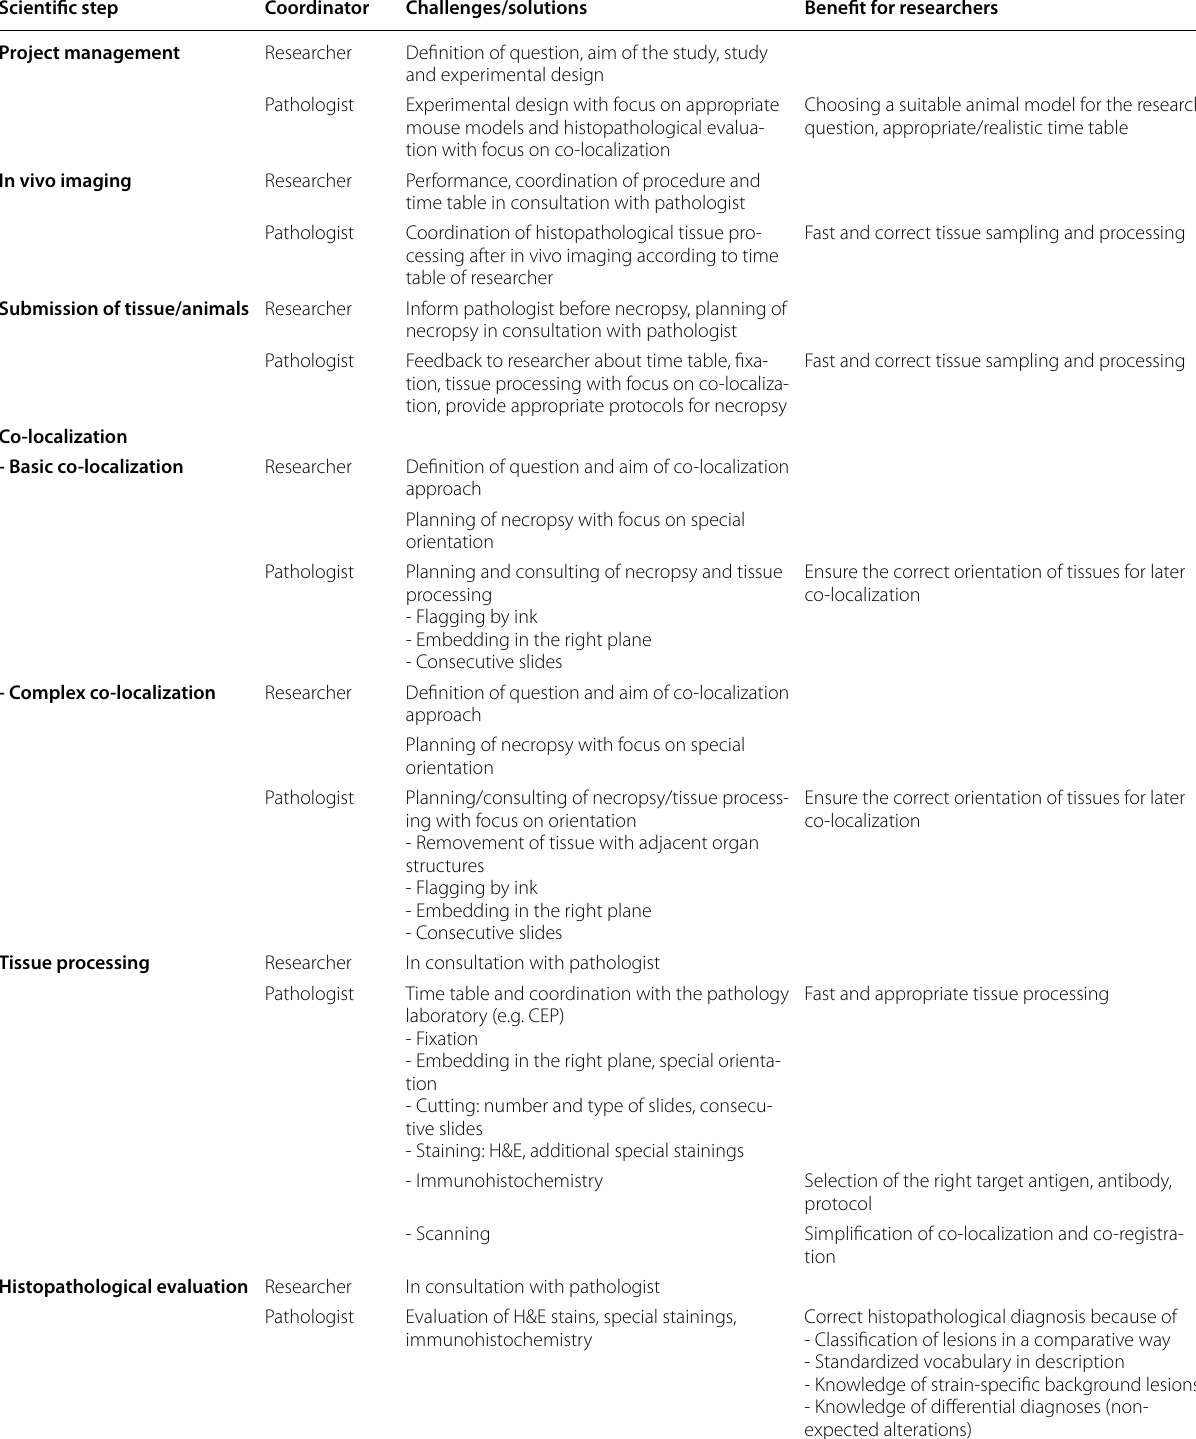
Table 2 Challenges and benefits of interdisciplinary cooperation between researchers and pathologists in translational oncology